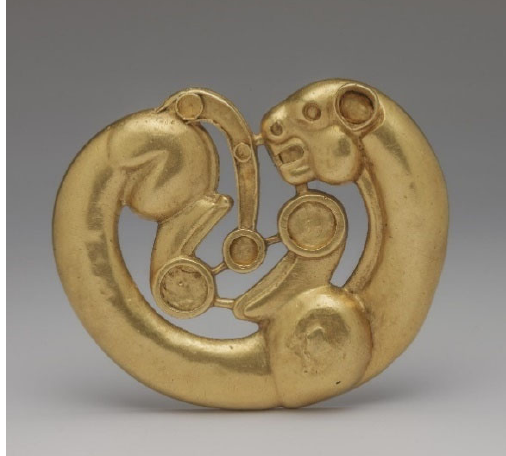
Figure 7. Plaque in the form of a coiled feline (SHM inv. no. C и .1727 ‐ 1/88); chased gold; Siberian Collection of Peter I; 7th to 6th century BC. [Image is used from www.hermitagemuseum.org (accessed 9 November 2022), courtesy of the State Hermitage Museum, St. Petersburg, Russia].